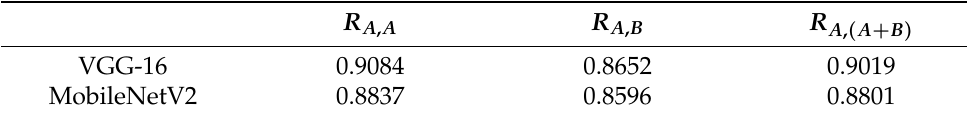
Table 3. Accuracy results after training Task A.